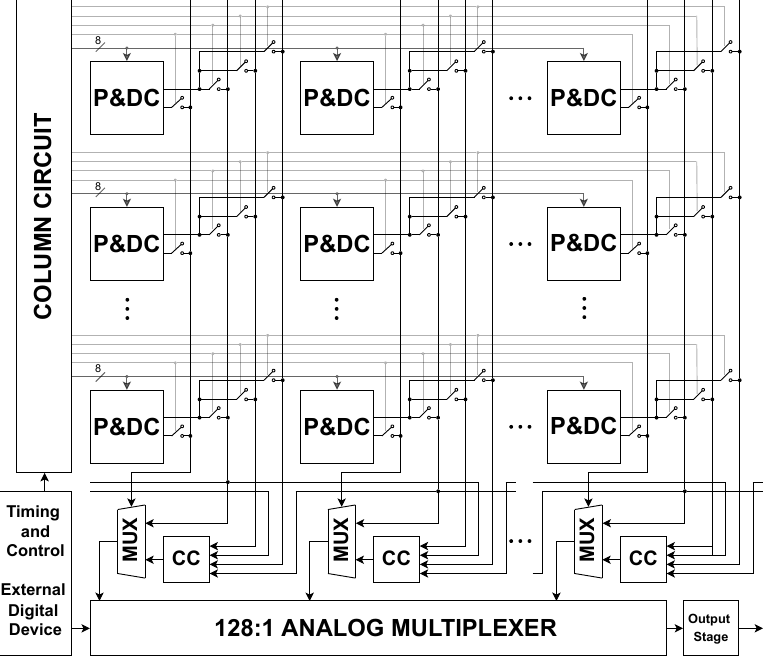
Figure 7. Smart pixel